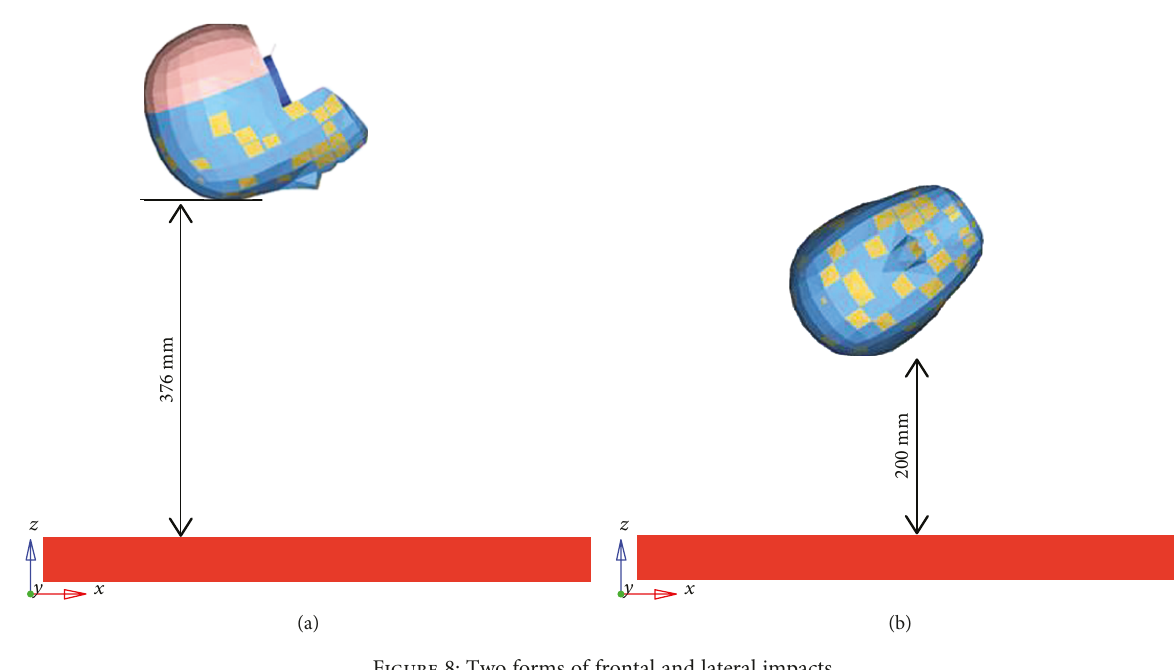
Figure 8: Two forms of frontal and lateral